Question: Which visualization type does this figure use?
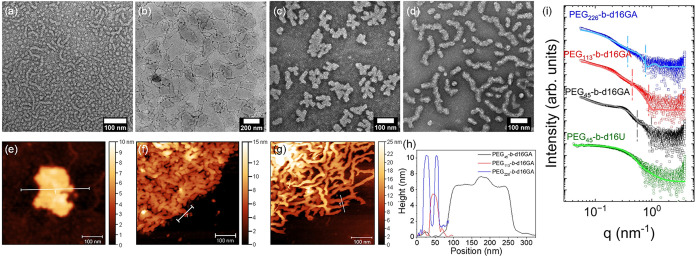
Answer: scatter